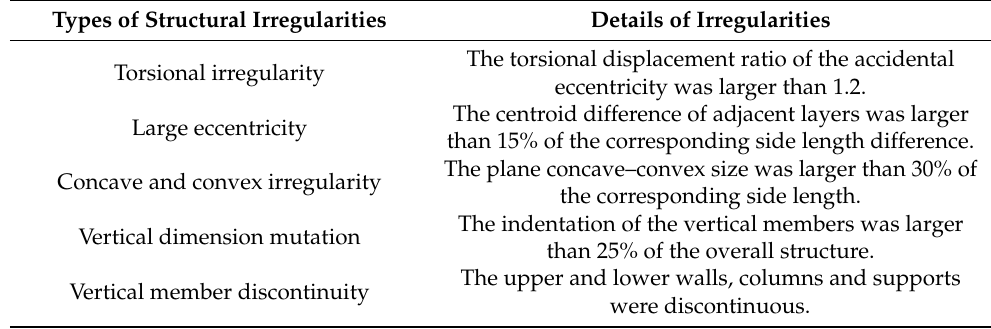
Table 3. The structural irregularities of Building G1.